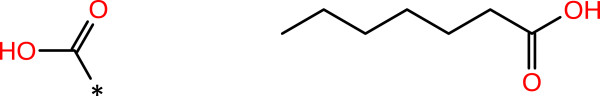
Carboxylic acid pattern and heptonic acid. A carboxylic acid pattern (left) with ‘*’ indicating any atom. Heptonic acid (right).